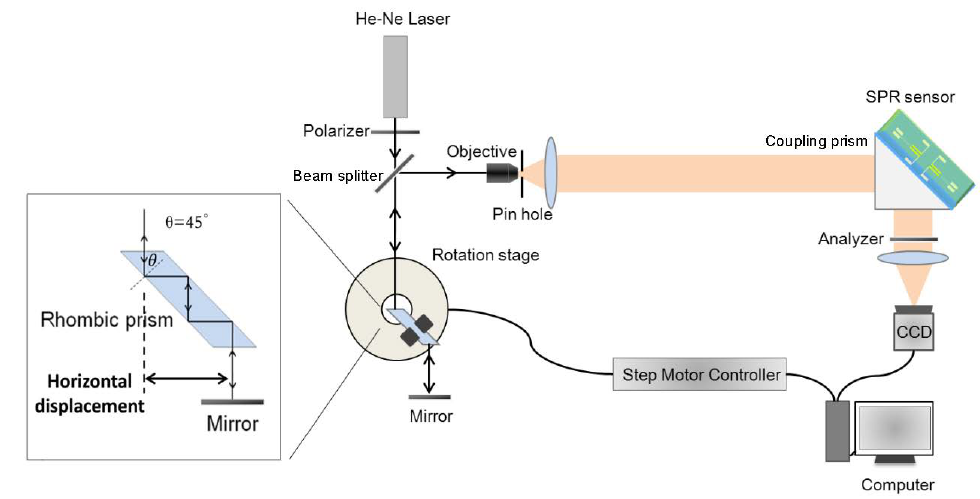
Figure 3: Schematic diagram of PPM-based phase-sensitive SPR sensing system. The PPM is placed on a rotation stage.